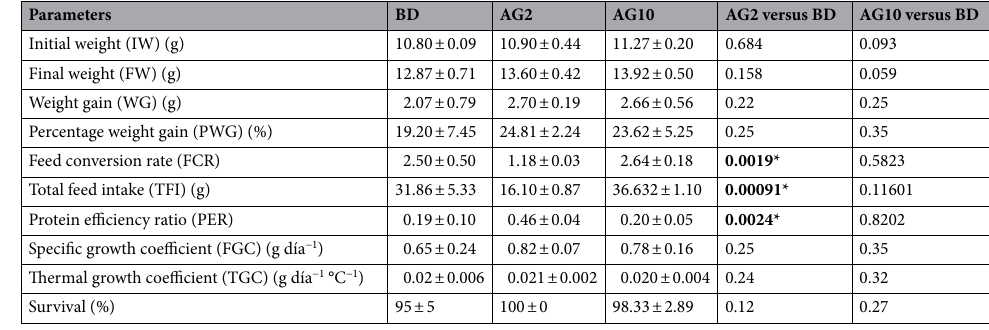
Table 2. Growth performance parameters of L. vannamei . Values represent means (± S.D.) for three diets with three replicates (n = 9). G2 versus BD and AG10 versus BD columns represent the p-value for each comparison obtained with a Wilcoxon test.All parameters were determined following the formulas mentioned in the methodology. *Indicates significant p -values < 0.05. Significant values are in